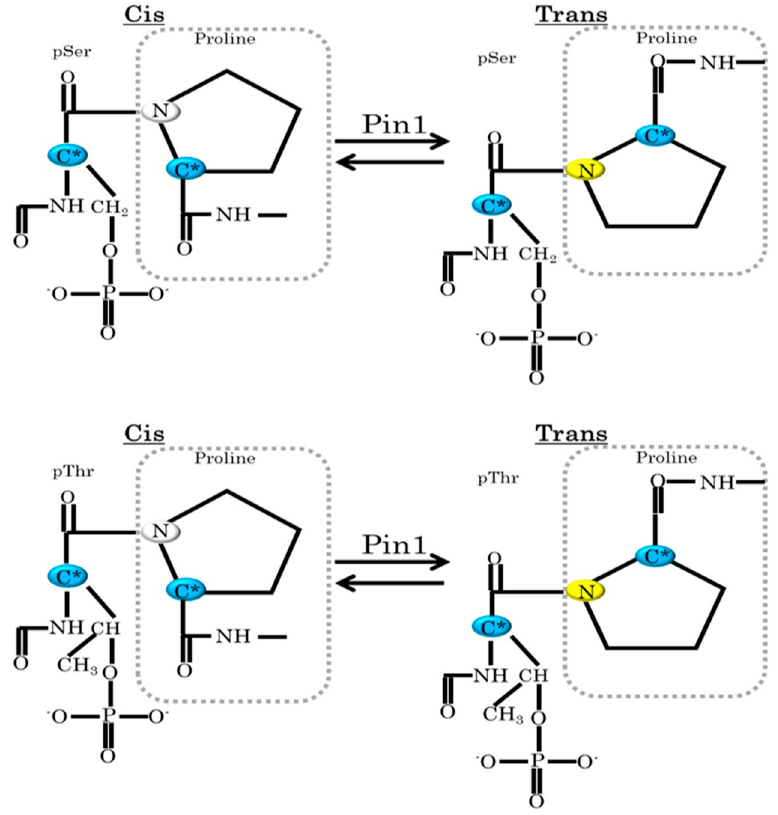
Figure 1. Pin1 recognizes the motif including pSer/pThr-Pro and catalyzes substrates. C*: asymmetric